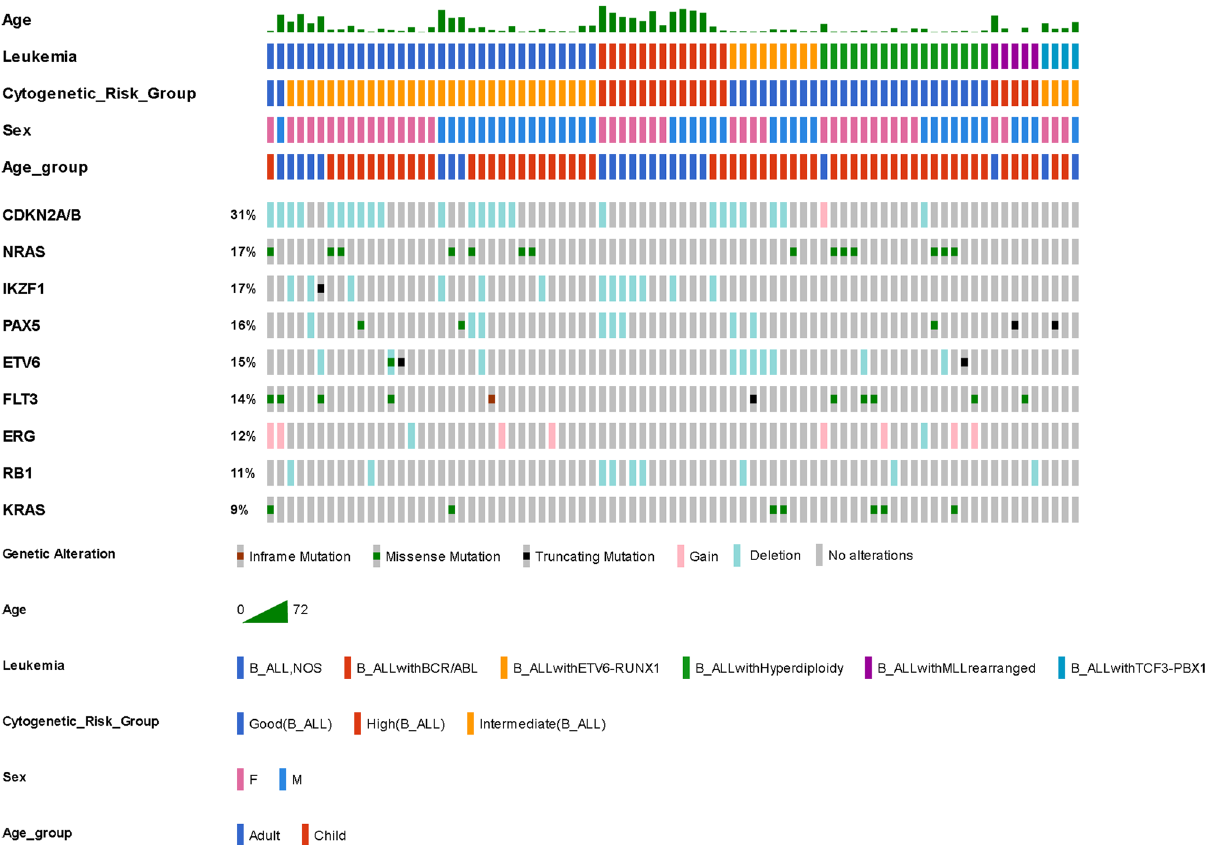
Figure 2. Most common genetic alterations in B-cell lymphoblastic leukemia/lymphoma (B-ALL). Only ≥ seven patients with gene-alterations are shown in the figure. Data were analyzed by OncoPrinter (cBioPortal Version 1.14.0, Gao et al., Sci. Signal. 2013 and Cerami et al., Cancer Discov. 2012). Truncating mutations (nonsense, frameshift deletion, frameshift insertion, splice site); inframe (inframe deletion, inframe